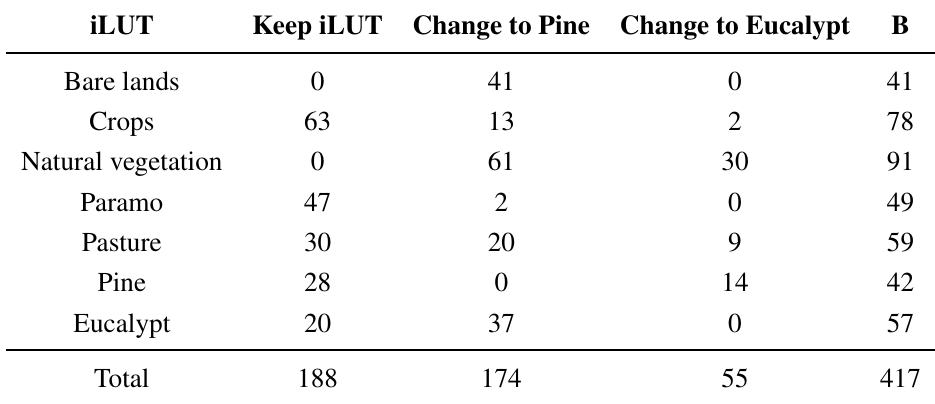
Table 3. Land use type distribution resulting from the application of the CP